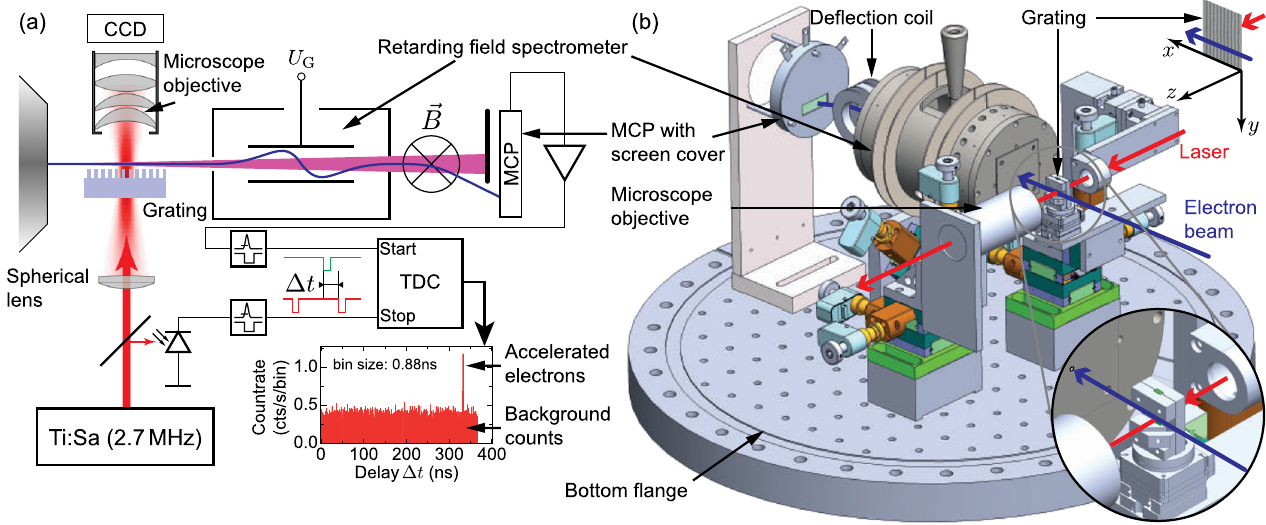
FIG. 2 (color online). (a) Conceptual picture of the electron acceleration detection. Electrons (blue trajectory) are emitted from an electron column (left) and interact with the laser pulses (red line), derived from a Titanium:sapphire oscillator, at the fused silica grating. A microscope objective is used to monitor the position of the laser focus. The electrons pass through a retarding field spectrometer, which blocks all unaccelerated electrons (counter voltage U ), and are detected with a MCP. The trajectory entering the spectrometer is G ⃗ B drawn as slightly offcenter to illustrate the effect of the retarding field. A magnetic field deflects the electrons around an x-ray beam stop to separate them from high energy photons originating inside the electron column. A time-to-digital converter (TDC) is used to measure the time delay Δ t between a detector event and the following laser pulse. This way, a signal of accelerated electrons appears at a fixed Δ t in a histogram while background counts are distributed equally over all delays (inset). (b) Technical drawing of the experimental setup with zoom-in of the grating and interaction region. The experiment is placed inside a vacuum chamber (base flange size DN 350 CF) evacuated to ∼ 5 × 10 − 7 mbar. The microscope objective ( xyz -degrees of freedom), the spectrometer ( yz -degrees of freedom) and the grating mount ( xyz -degrees of freedom) can be positioned relatively to the electron beam with motorized translation stages. Additionally, the grating can be fine positioned with stick-slip piezoelectric actuators (translation in z -direction and rotation in xz -plane). The achromatic lens which is used to focus the laser pulses can be manually positioned with a compact dovetail linear